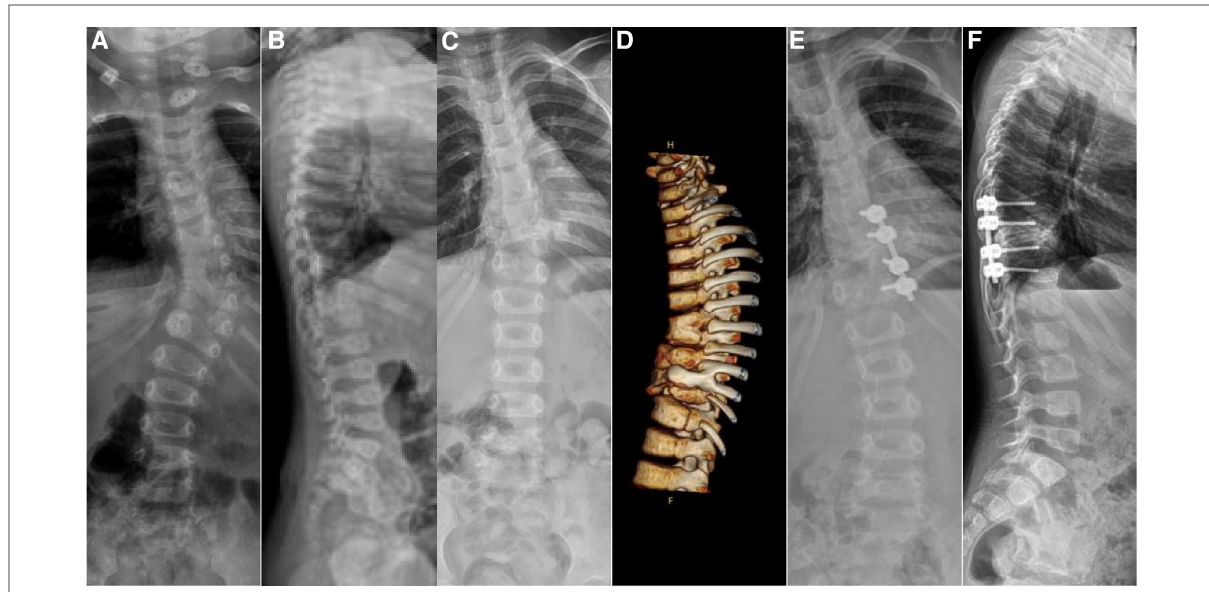
FIGURE 3 Case 2, female, 6 months old. Preoperative orthogonal ( A ) and lateral ( B ) x-ray showing the left hemivertebrae of T10. Intraoperative hemivertebra resection was performed via the posterior approach. After 4 years of follow-up, orthogonal x-ray ( C ) and lateral computer tomography ( D ) showed good correction of coronal scoliosis, but sagittal kyphosis was aggravated, and a second internal fi xation revision surgery was performed. Post- revision orthogonal ( E ) and lateral ( F ) x-ray showed good correction of the coronal and sagittal deformity.